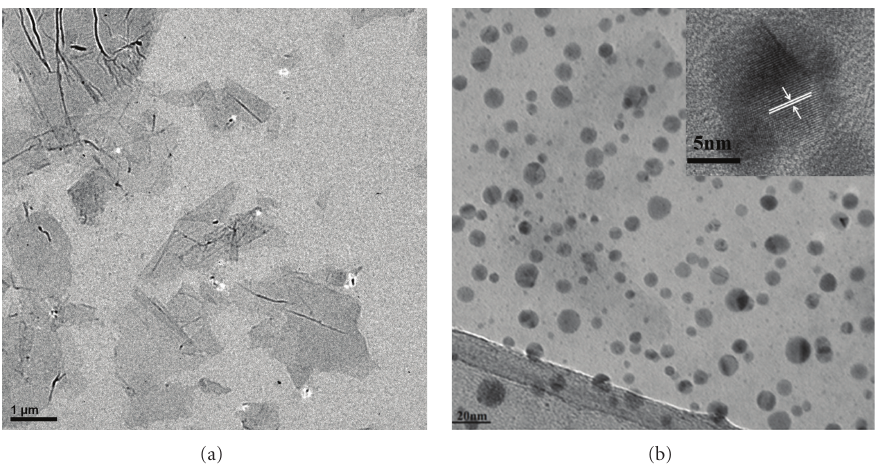
Figure 1: (a) TEM image of bare GO; (b) TEM and HRTEM image of RGO -